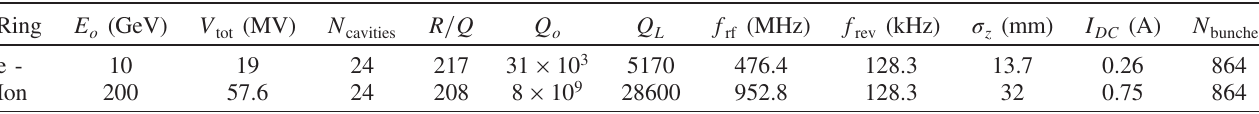
TABLE I. Example ring and rf system parameters used in this study. Ring E o